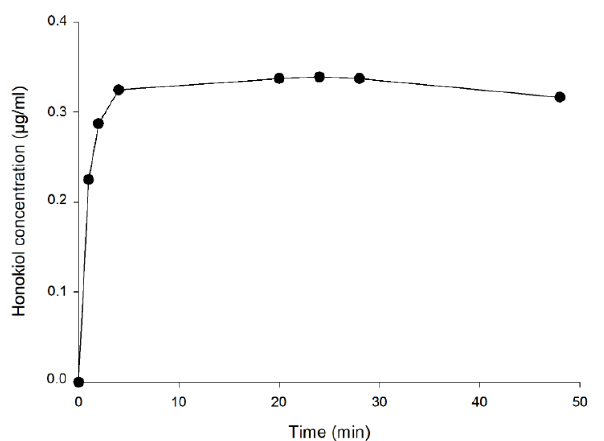
Figure 8. Concentrations of honokiol in the external aqueous medium during the dialysis test.